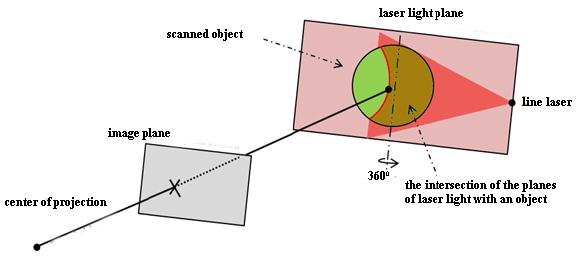
Figure 3. The scanning scheme of the FabScan scanner Within the assumption that the position of the laser and the camera are known (and constant), there can be also calculated the equation of the plane of the laser beam, and also the equation of the camera radium responding to lit points on the object. The position of the lit points is designated by the cross of the laser beam plane with camera radius. Through the rotation of the object by 360 ◦ during the scanning process, all the sides of the object are lit. It makes obtaining the 3D model possible (Lanman, Taubin, 2009).